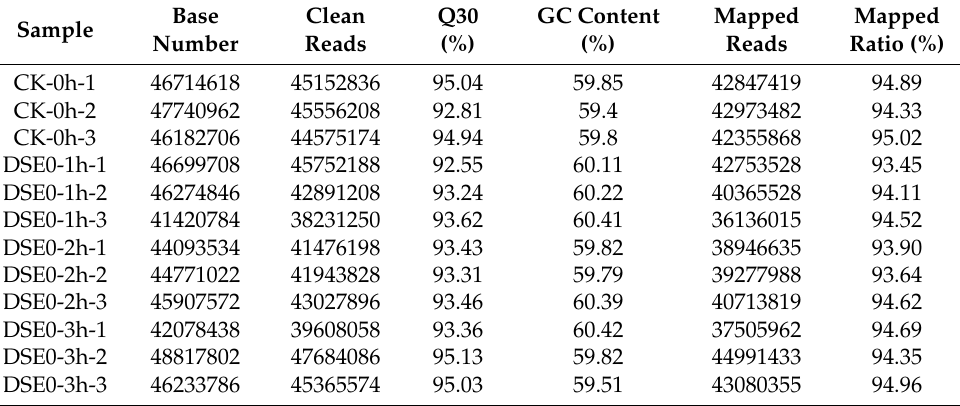
Table A2. Summary of RNA-seq reads in CK-0h and treatments (DSEO—1 h, DSEO—2 h, DSEO—3 h) groups of N. parvum